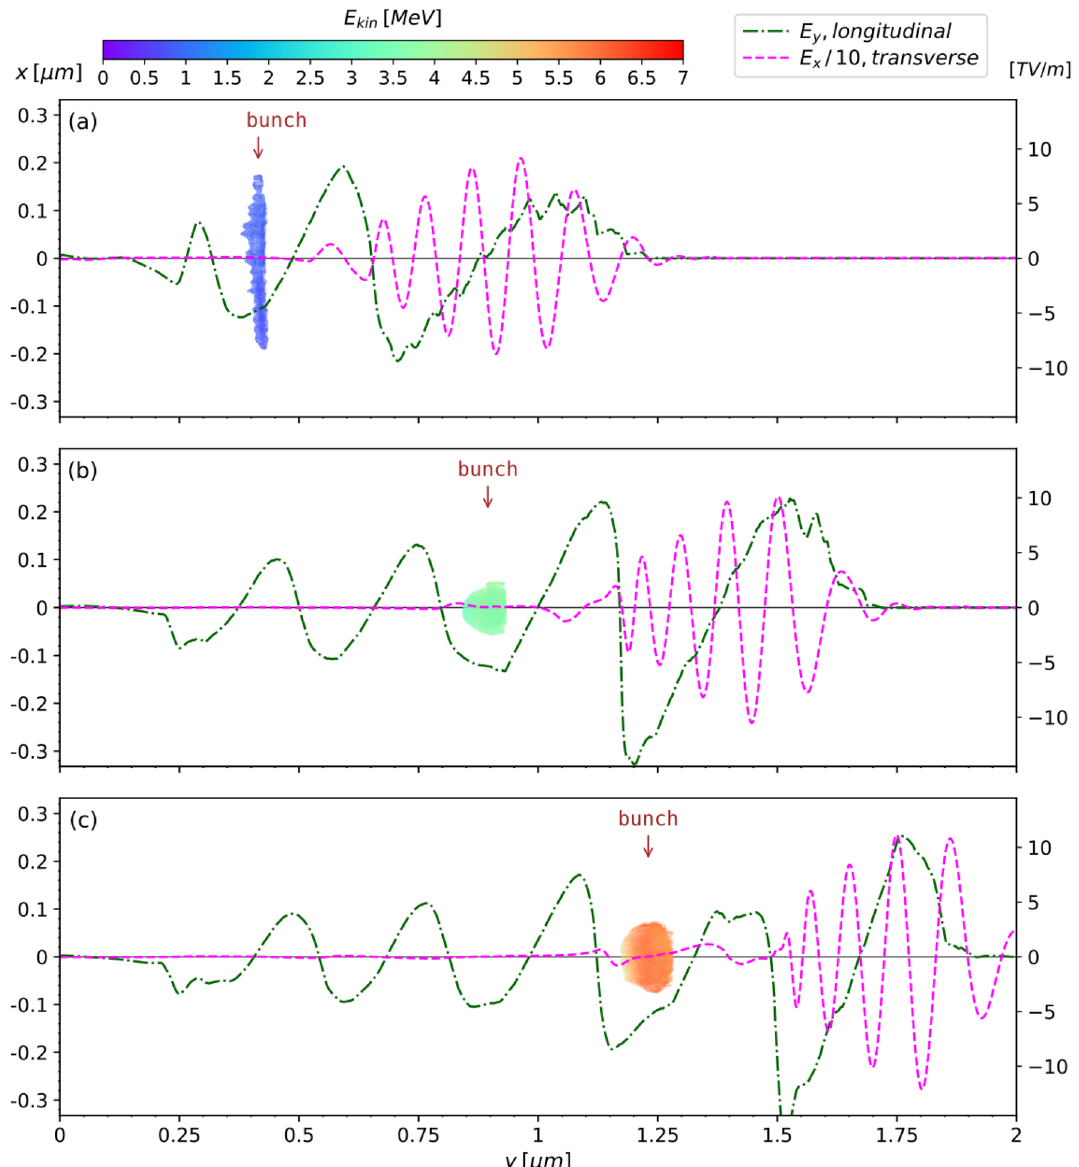
Figure 4. On-axis longitudinal electric field E y and transverse electric field E x arising mostly from the laser pulse, overlapped with the electron bunch at: ( a ) t / T = 13.7, ( b ) t / T = 19 and ( c ) t / T =